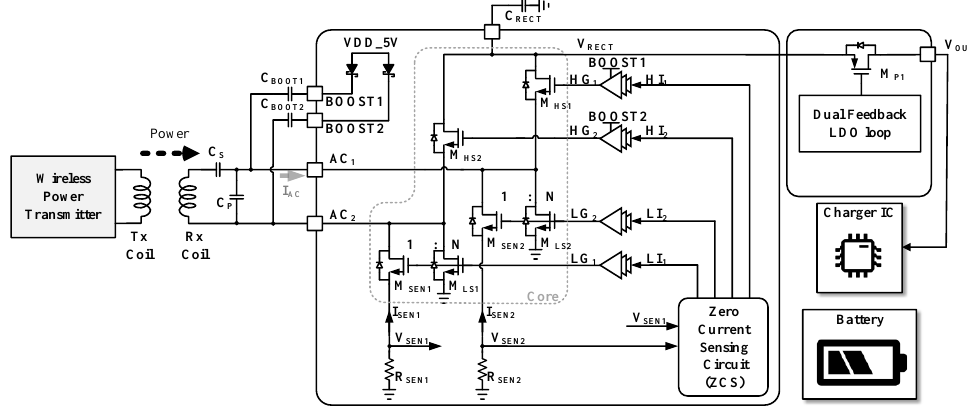
Figure 2. Block diagram of the active rectifier.